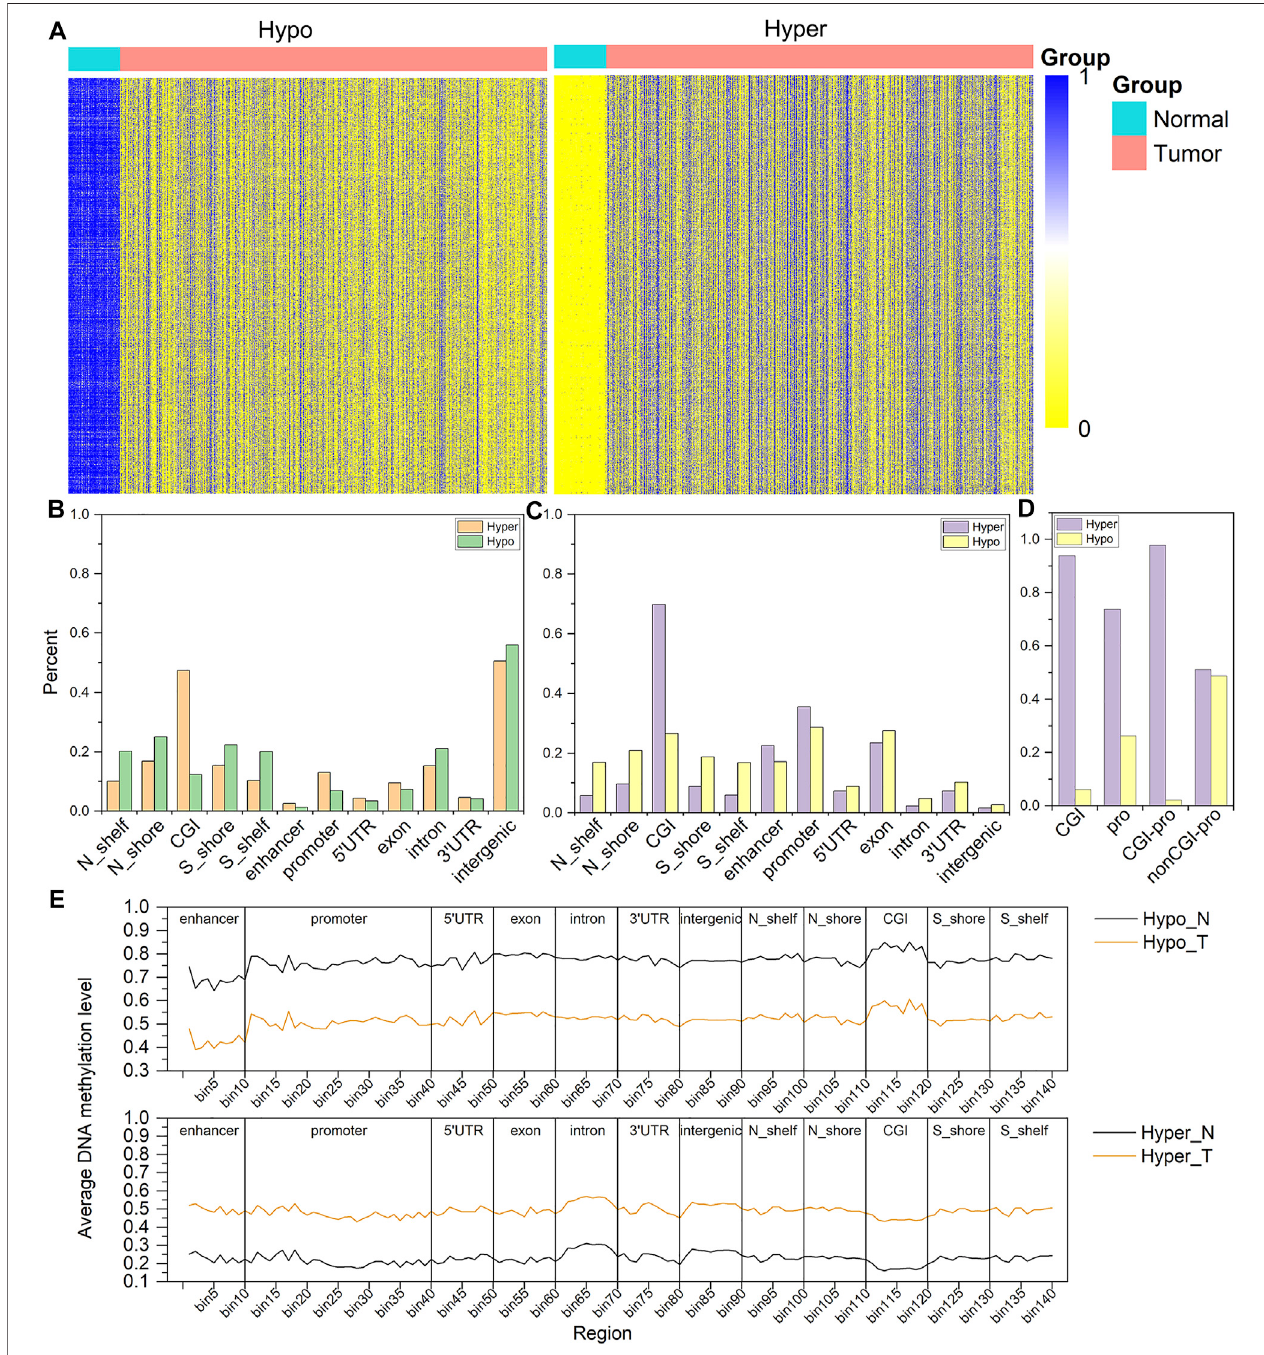
FIGURE1| DistributionmapofDNAmethylationinthewholegenome. (A) isthemethylationvalueofhypomethylation(Hypo)andhypermethylation(Hyper)probes in different samples, the rows are the methylation values of each probe, and the columns are the different samples. (B) is the density distribution of DNA methylation probes in each functional region of the genome. (C) is the density distribution of DNA methylation probes in each functional region of the genome normalized by length. (D) isthedistributionratiodiagramofthehyperandhypomethylationprobesoftheCGIandthepromoterregion, (E) isthedistributionofaverageDNAmethylation levelsin12regionsofADMPsinparacanceroustissues.(N)andbreastcancertissues(T).Theabscissabin1-bin140isdividedinto12regionsby11verticallines,andthe upper coordinate is the name of each region.